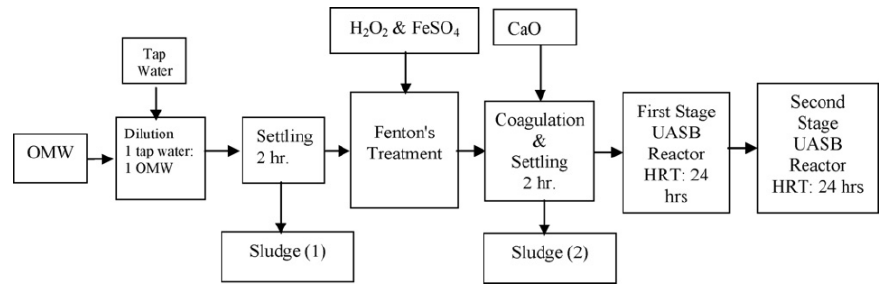
Figure 2. Treatment of OMW using the combined Fenton catalytic oxidation process and the anaerobic sludge two-staged blanket reactor. Reprinted with permission from Reference [55]. Copyright 2012 Elsevier.